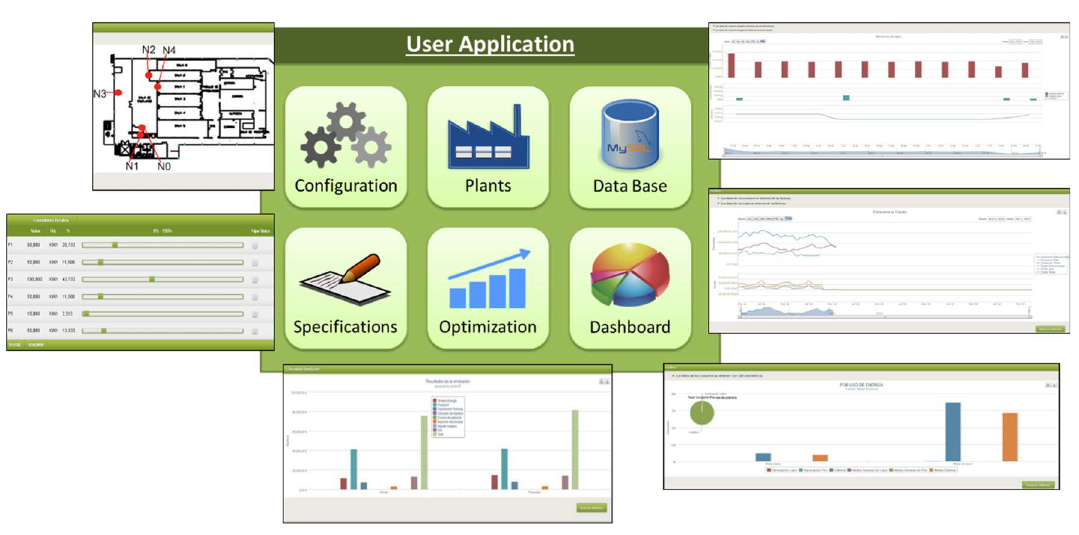
Figure 9. Graphical examples of the HMI.